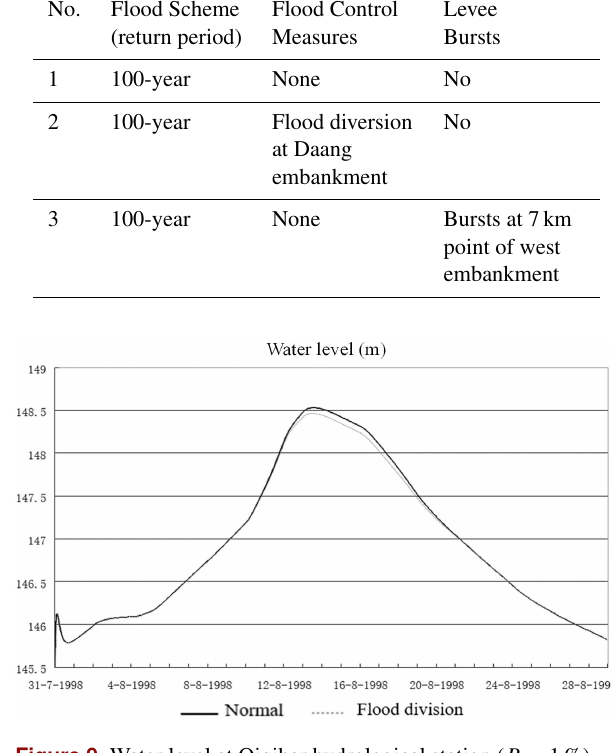
Figure 9. Water level at Qiqihar hydrological station ( P = 1%).